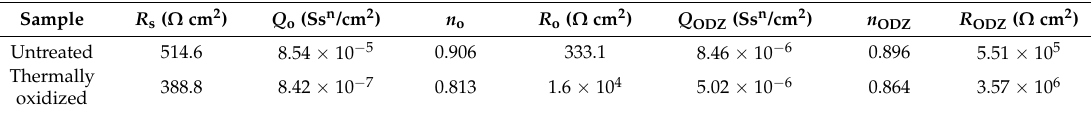
Table 3. Electrochemical impedance